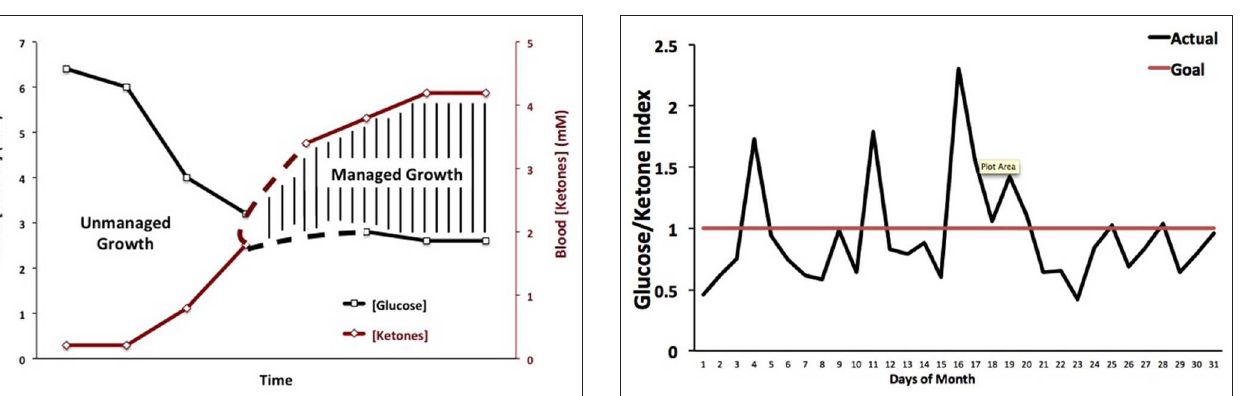
FIGURE 3 | Linkage of plasma glucose and ketone body levels to cancer management. The glucose and ketone (beta-hydroxybutyrate) values are within normal physiological ranges for humans that are under water-only fasting. This state is considered the zone of metabolic management for most cancers. The zone of metabolic management is obtained gradually, as circulating levels of glucose fall and ketones rise. the Glucose Ketone Index (GKI) tracks the transition to therapeutic ketosis. The dashed lines highlight individual variability that could exist in reaching a therapeutic GKI. GKI values approaching 1.0 and below are considered potentially therapeutic. [Reprinted from Meidenbauer et al. ( 197), and distributed under a Creative Commons license].